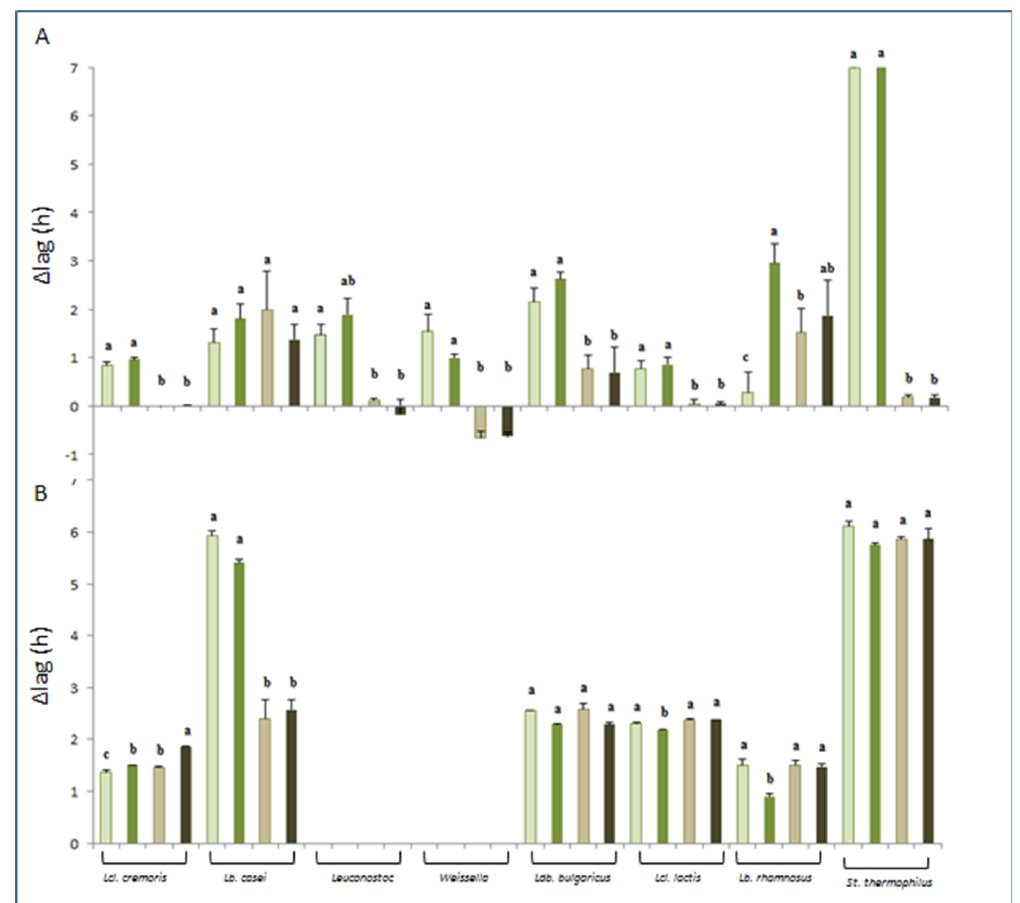
Figure 2. Boosting effect of A. platensis showed as mean Δ lag valuesin Tryptic Soy Broth (TSB) ( A ) and in reconstituted skim milk powder (SSM) ( B ). a–b Different lowercase letters by column within the same mix culture indicate the presence of significant di ff erences according to Analysis of Variance ANOVA ( p < 0.001). Light green bars represent 0.25% of sterilized A. platensis (SP) and dark green 0.5%; light and dark brown bars represent respectively 0.25% and 0.5% of yeast extract (Oxoid)